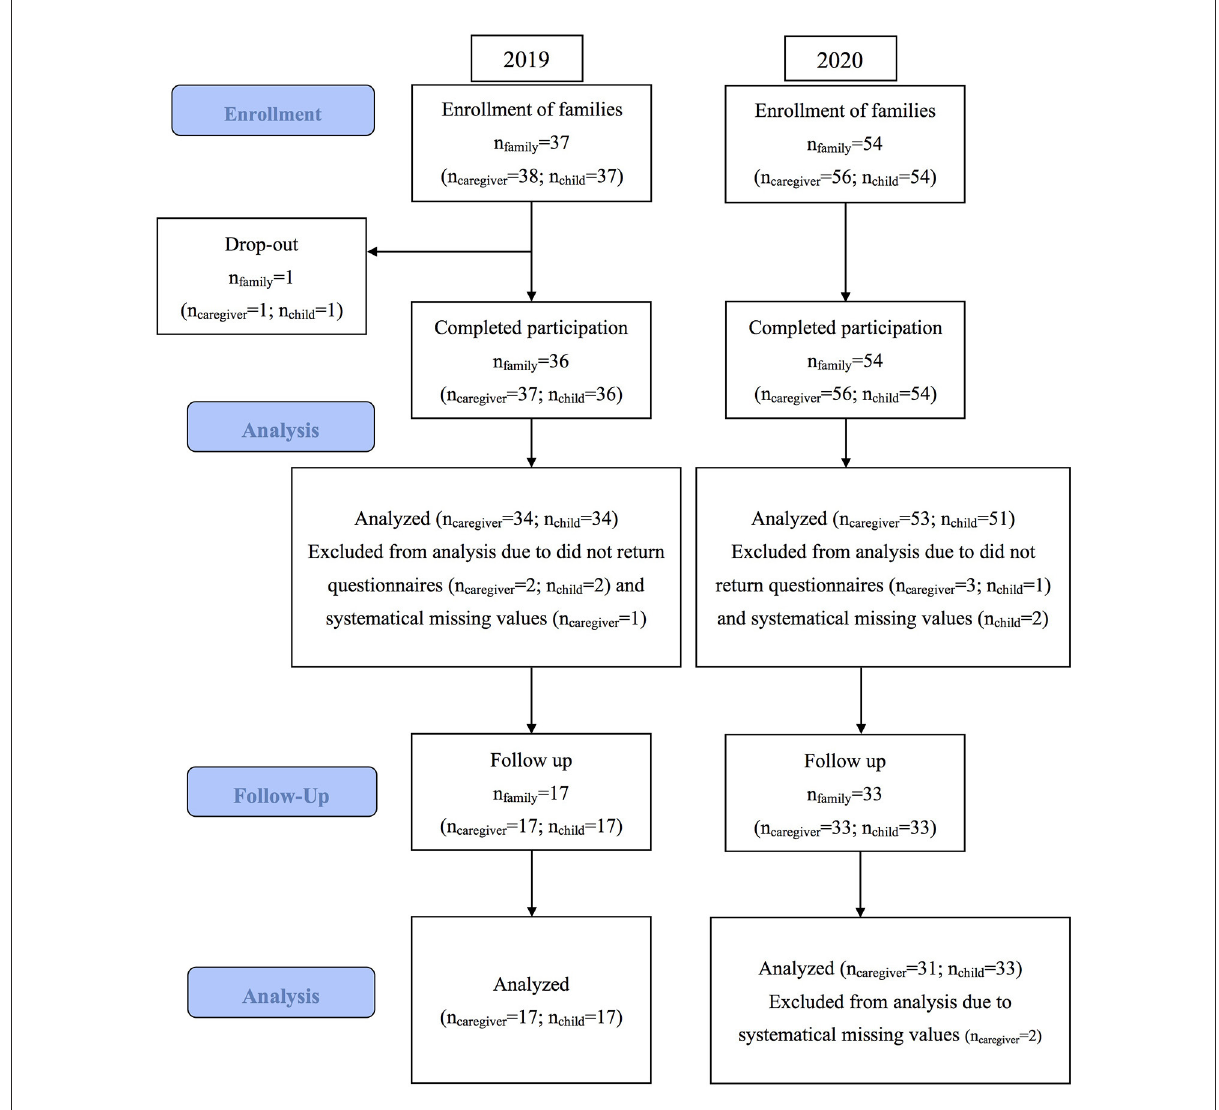
FIGURE3 CONSORT flow